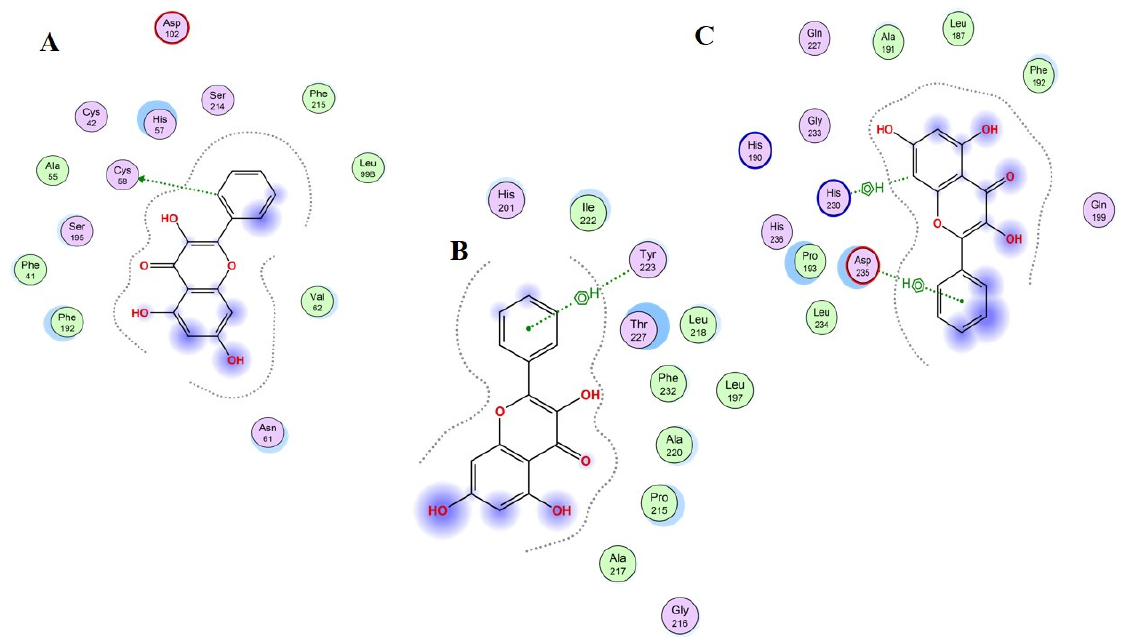
Figure 11. Schematic representation of Compound 12 “galagin” bonded in the active site of selected three proteins (PDB ID: 1H1B ( A ), 1QIB ( B ) and 4H1Q ( C )). The active binding site shows hydrogen- bonding capacity as donor atoms (purple), and acceptor atoms (green), a two-dimensional plot showing hydrogen bonding interactions and other important hydrophobic interacting residues of the target proteins.